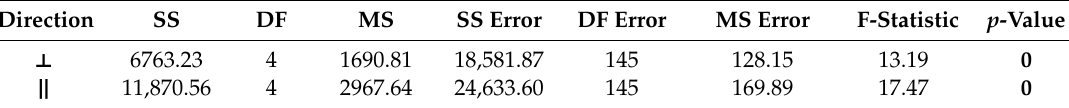
Table 4. Tukey’s honest significant difference (HSD) test, p-values.